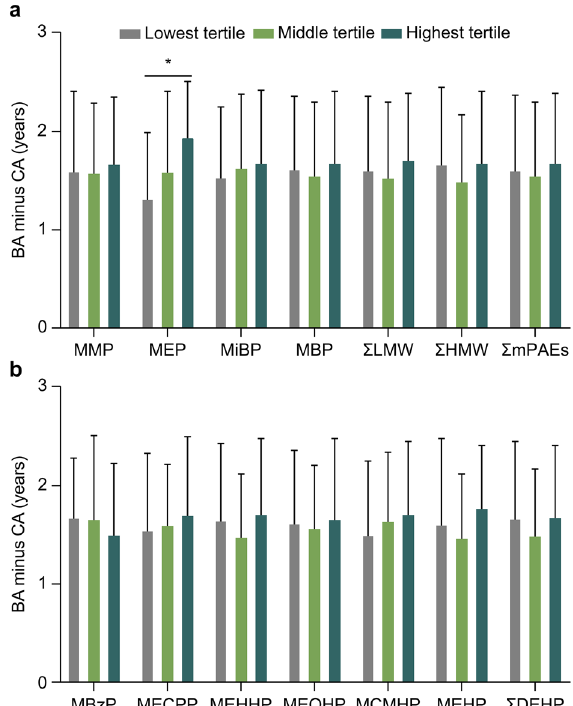
Figure 2. Bone age (BA) advancement in tertiles of the ( a ) low molecular weight mPAEs, ΣLMW, ΣHMW, and ΣmPAEs; and ( b ) high molecular weight mPAEs and ΣDEHP. The degree of BA advancement in the highest MEP tertile was statistically higher than that in the lowest MEP tertile ( P < 0.05), as indicated by the asterisk (*). ΣDEHP: sum of the creatinine-corrected concentrations of MCMHP, MEHP, MEOHP, MEHHP, and MECPP. ΣLMW: sum of the creatinine-corrected concentrations of MBP, MMP, MiBP, and MEP. ΣHMW: sum of the creatinine-corrected concentrations of ΣDEHP and MBzP. ΣmPAEs: sum of the creatinine-corrected concentrations of all of the